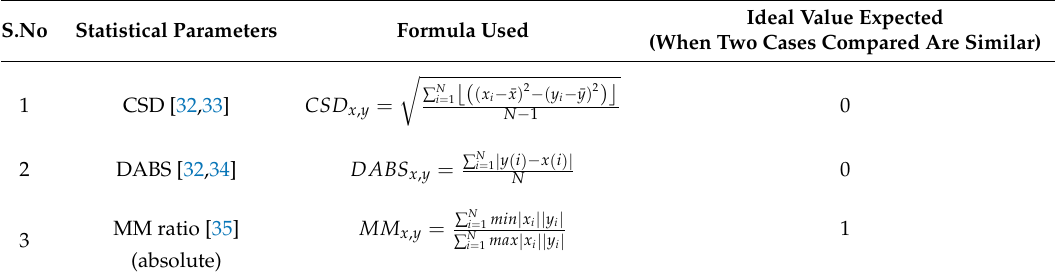
Table 2. Statistical parameters, notations, formula, and their ideal values.